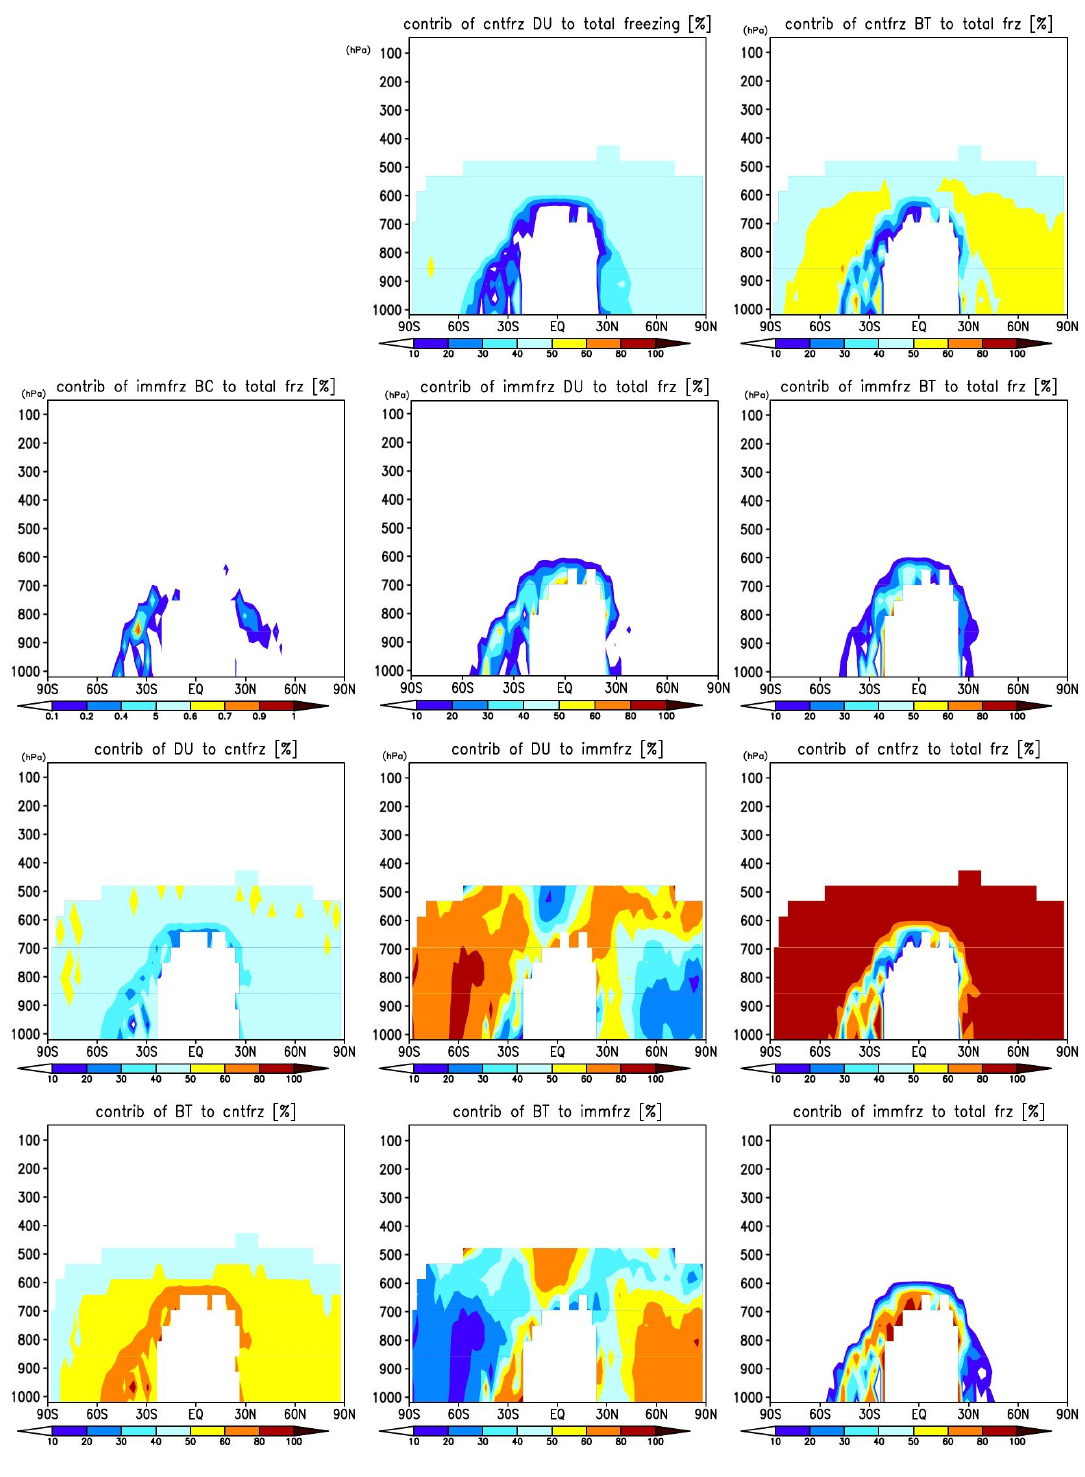
Fig. 8. Modelled annual zonal mean latitude vs. pressure cross sections of the percentage fraction of the different freezing mechanisms from simulation BT1 for bacteria, mineral dust and black carbon. Please note the different scale for black